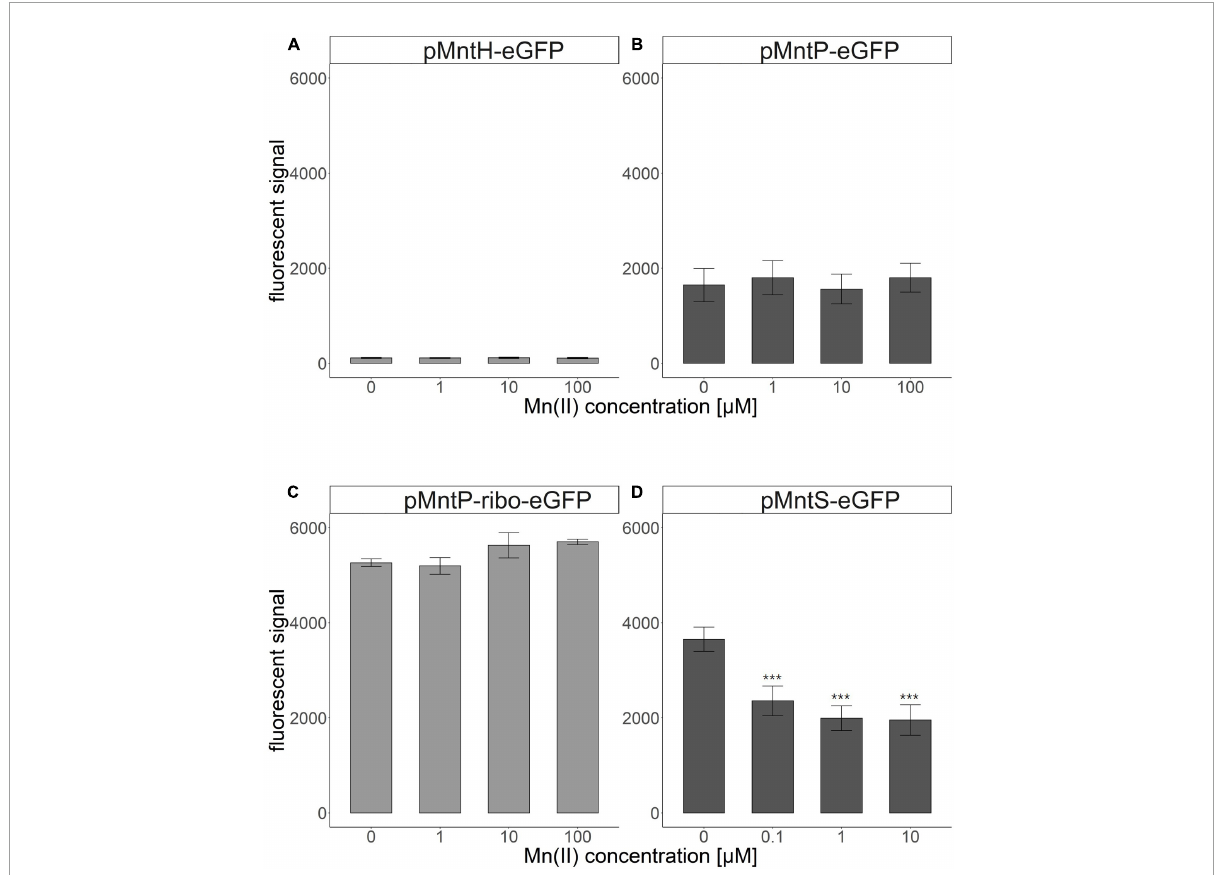
FIGURE2 Fluorescence signals of Escherichia coli cell-based biosensors upon Mn(II) exposure. (A) E. coli harboring pMntH-eGFP, (B) E. coli harboring pMntP-eGFP, (C) E. coli harboring pMntP-ribo-eGFP, and (D) E. coli harboring pMntS-eGFP. The data was obtained from more than three times of replicated experiments. The asterisks indicate that the data is significantly higher than the control data (Dunnett’s test, *** p <